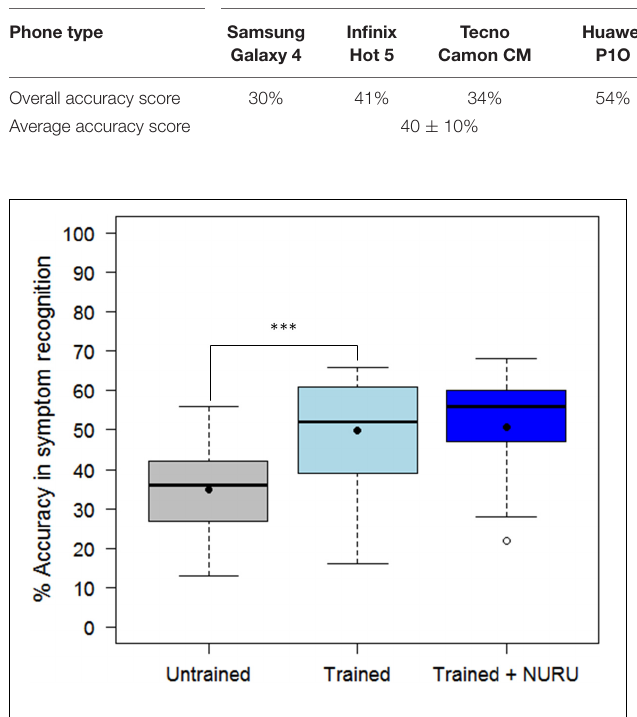
FIGURE 4 | Comparison of the ability of 30 agricultural extension officers and 50 farmers to accurately recognize symptoms of CMD, CBSD, and CGM-damage before and after receiving training on cassava pests and diseases. The black line within the boxes represents the median, the top and bottom of the box represent the 75th and the 25th percentiles, the whiskers represent the maximum and minimum values while the symbols ( represent the mean and the outlier.